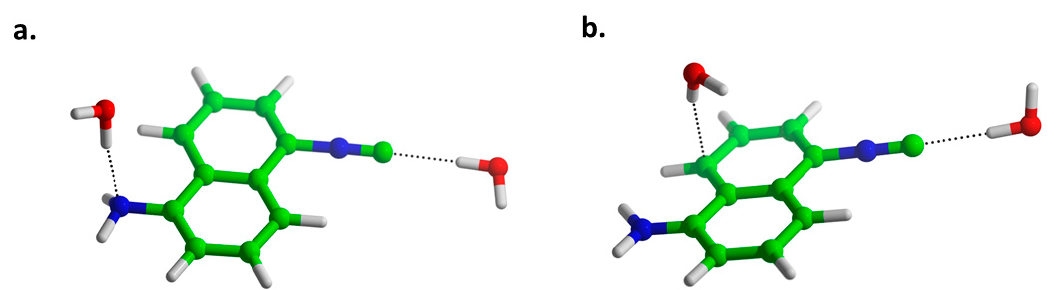
Figure 8. Solvent rearrangement in the ground- ( a ) and in the first relaxed excited state ( b ) for the 1,5-ICAN isomer in